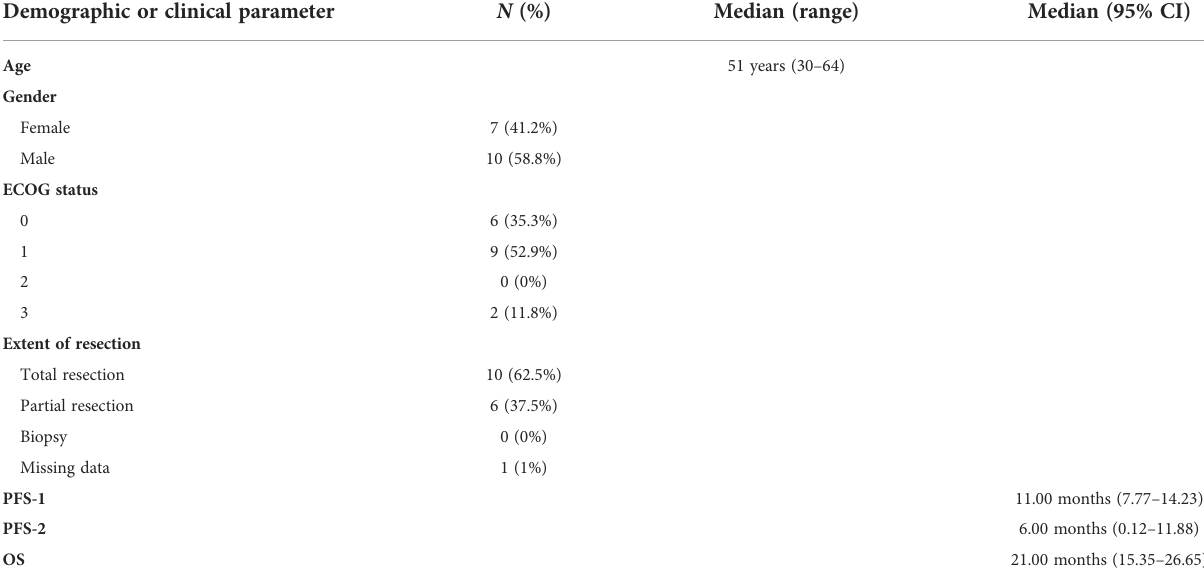
TABLE 2 Demographic and clinical parameters of patients submitted to